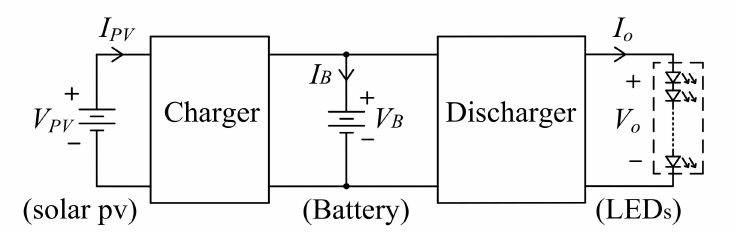
Figure 1. Block diagram of solar power system for electronic signor street-lighting application.